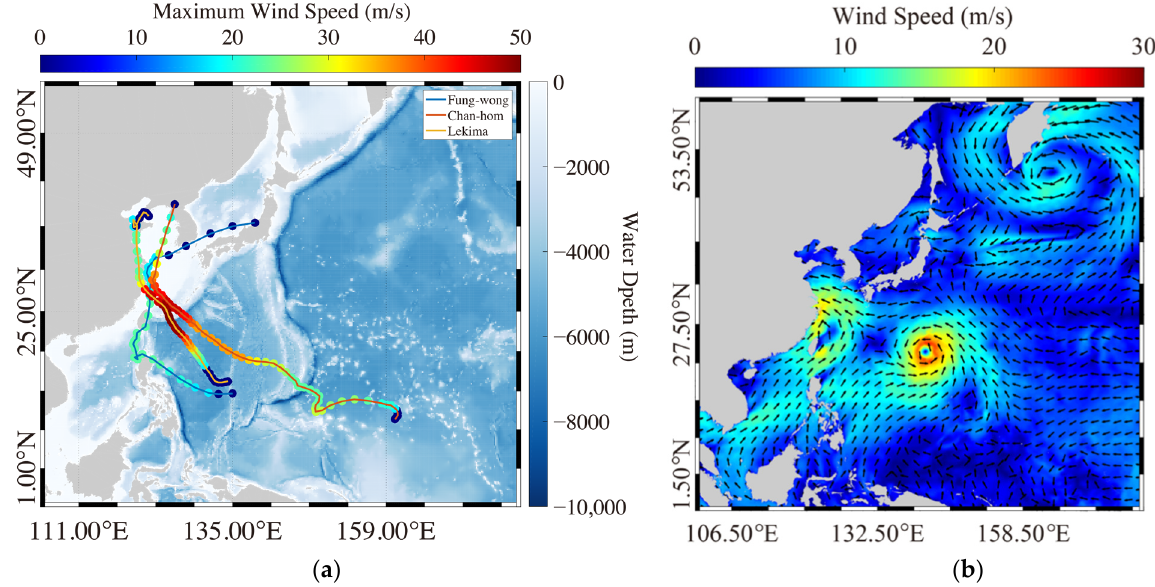
Figure 1. ( a ) The tracks of three typhoons with the measurements from moored buoys, overlaid by the General Bathymetry Chart of the Oceans (GEBCO) water depth. ( b ) The 0.1° gridded composite wind fields at 01:00 UTC on 10 August 2019.